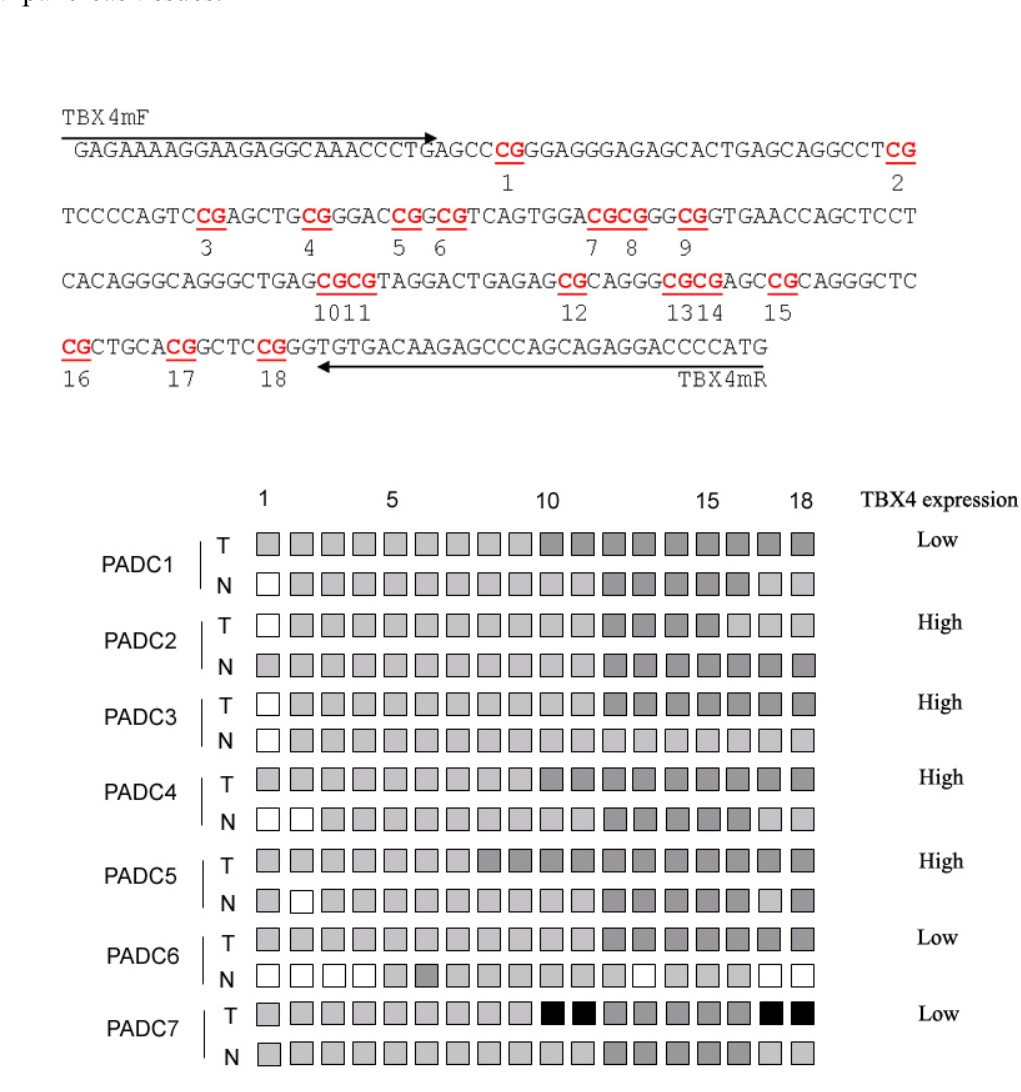
Figure 3. Methylation status of 18 CpG sites in the TBX4 promoter region ( − 1842 to − 1626) were analyzed in 7 PDAC tissues (T1-7) (3 cases were defined as low level of TBX4 expression, and the other 4 cases were defined as high level of TBX4 expression) and adjacent normal pancreas tissues (N1-7) ( A ); Black, gray, and white squares represent complete methylation, partial methylation, and unmethylation status at each CpG site, respectively ( B ). Methylation status was frequently observed in both PDAC and adjacent normal pancreas